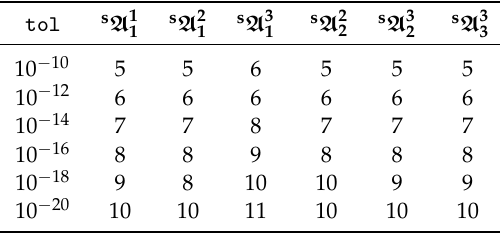
Table 2. Order parameter L of the Padé approximants [ 2 L constructed by the algorithm in [35] for six independent entries of the symmetrized α -effect tensor s A .